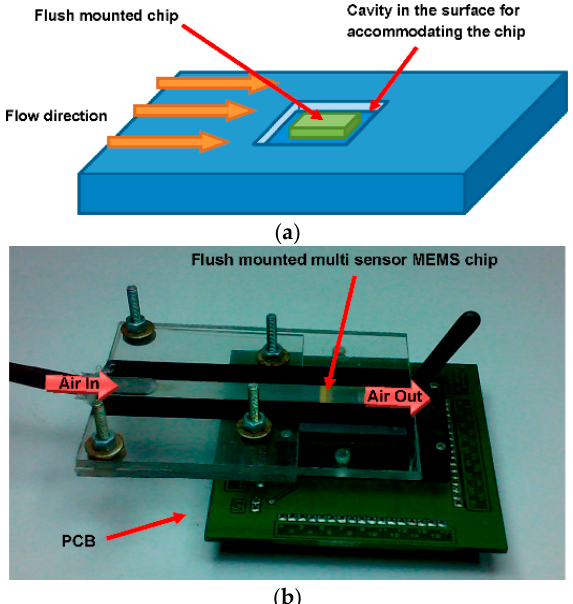
Figure 9. ( a ) Schematic diagram of the packaged multi-sensor MEMS chip for simultaneous